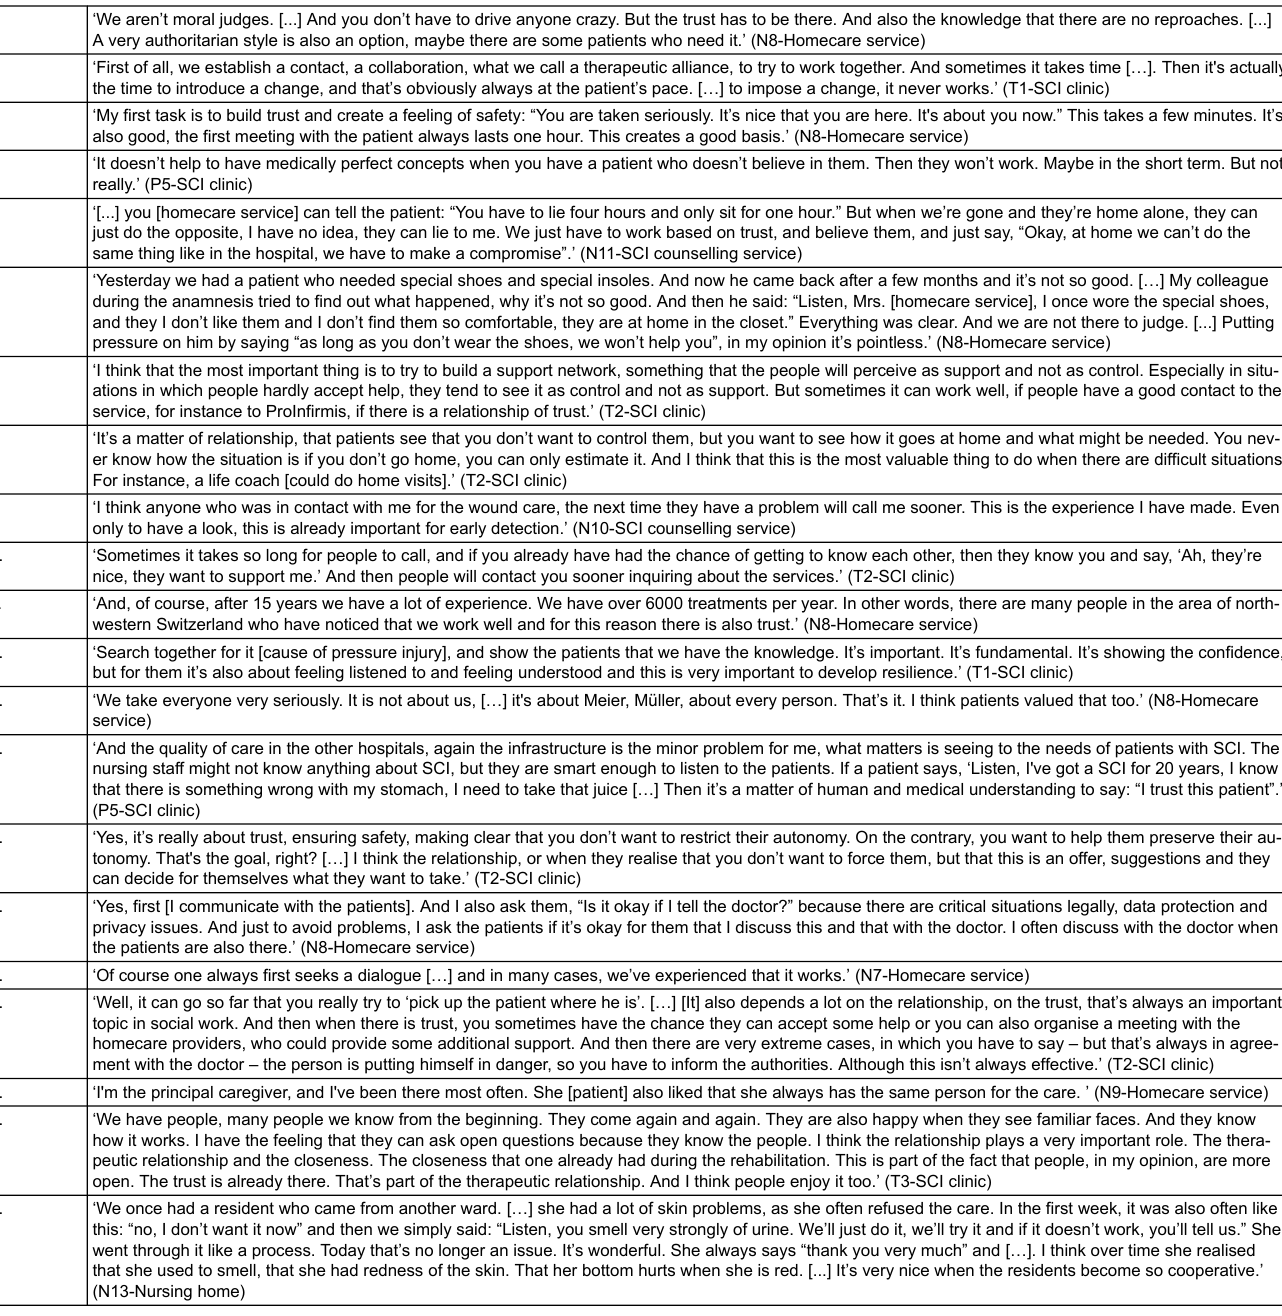
Table 5: Challenge 3 – building a basis of mutual trust and